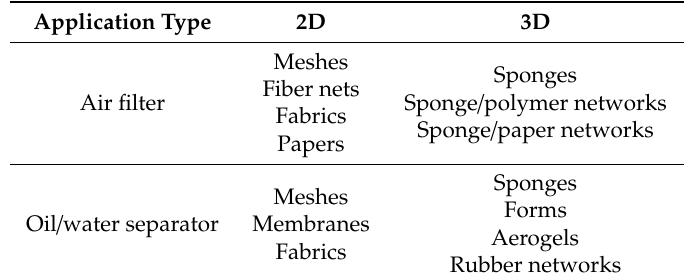
Table 1. Typical 2D and 3D bulk materials for air filters and oil / water